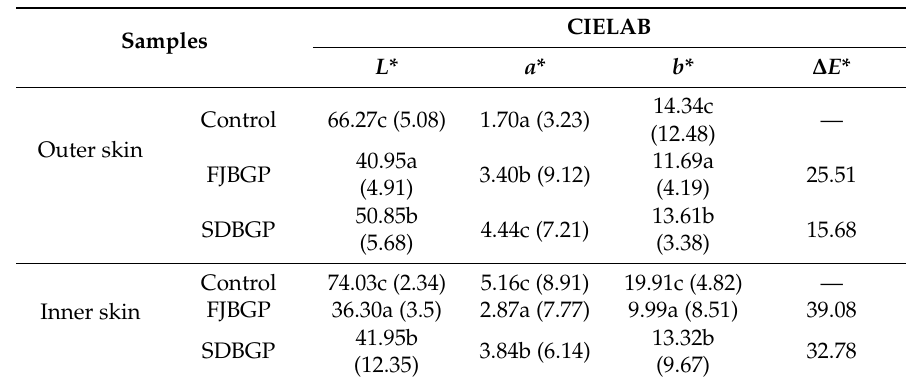
Table 3. Color changes of used BGP and control